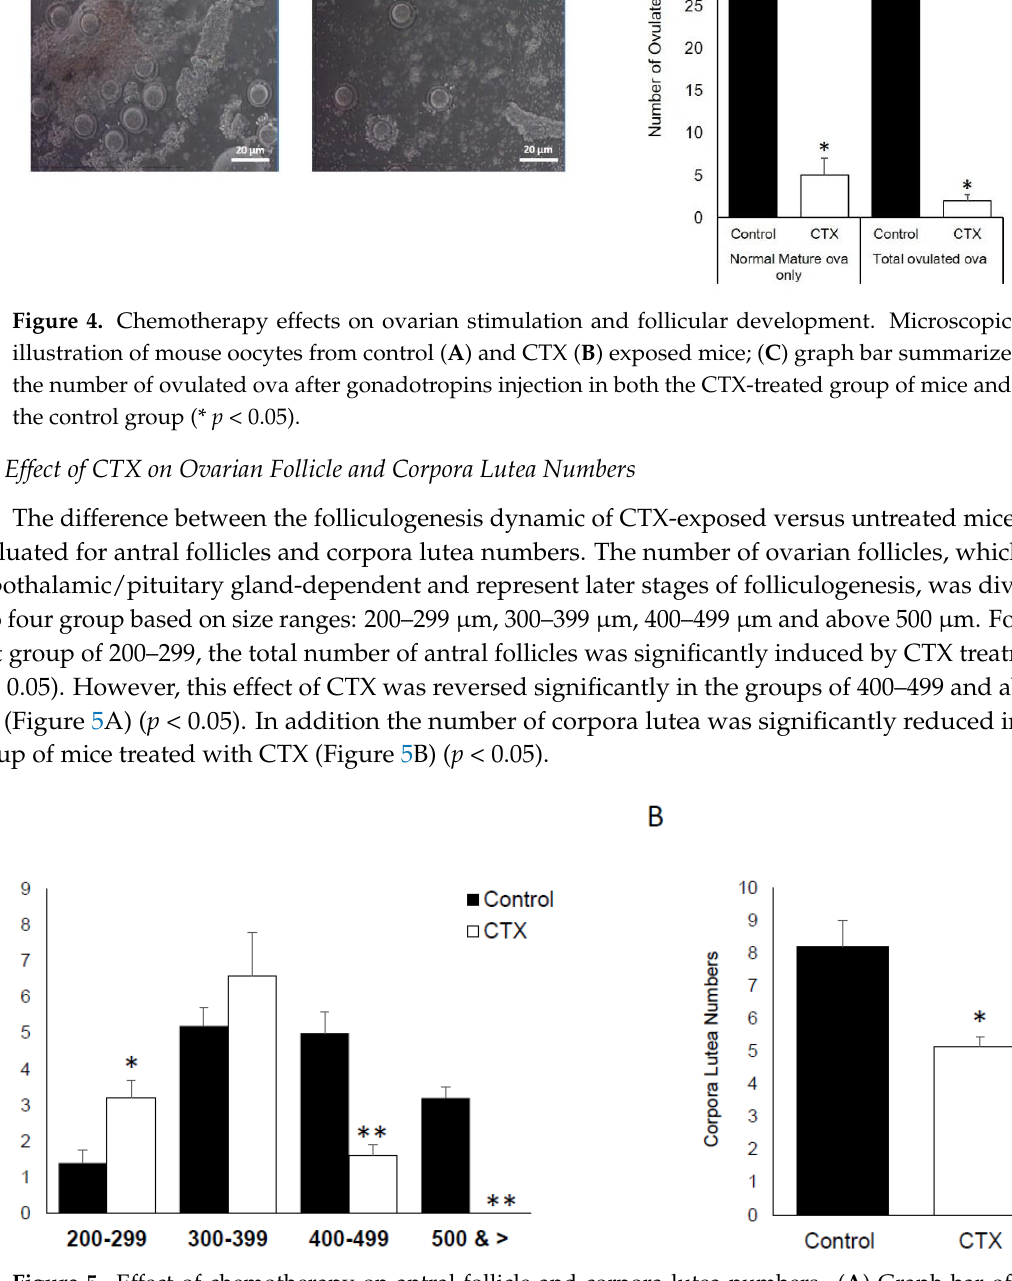
Figure 5. Effect of chemotherapy on antral follicle and corpora lutea numbers. ( A ) Graph bar of antral follicle number in CTX treated group versus untreated control group (* p < 0.05, ** p < 0.005); ( B ) numbers of corpora lutea formed following ovulated ova in the CTX treated group versus control group (* p < 0.05).